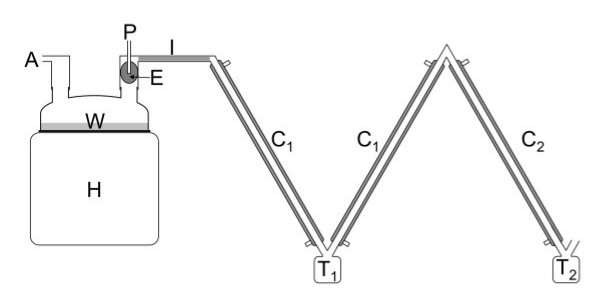
Experimental apparatus. A = air inlet, H = humidifier, W = water, P = perfluorocarbon inlet, E = perfluorocarbon evaporator, I = heated inspiratory line, C1 = 1°C condenser, C2 = -30°C condenser, T1, T2 = traps.